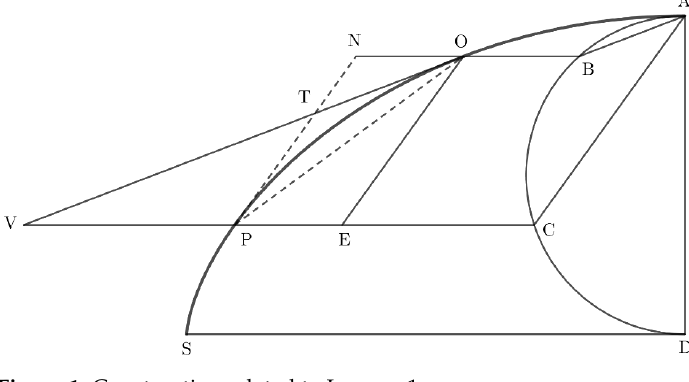
Figure 1. Construction related to Lemma 1.